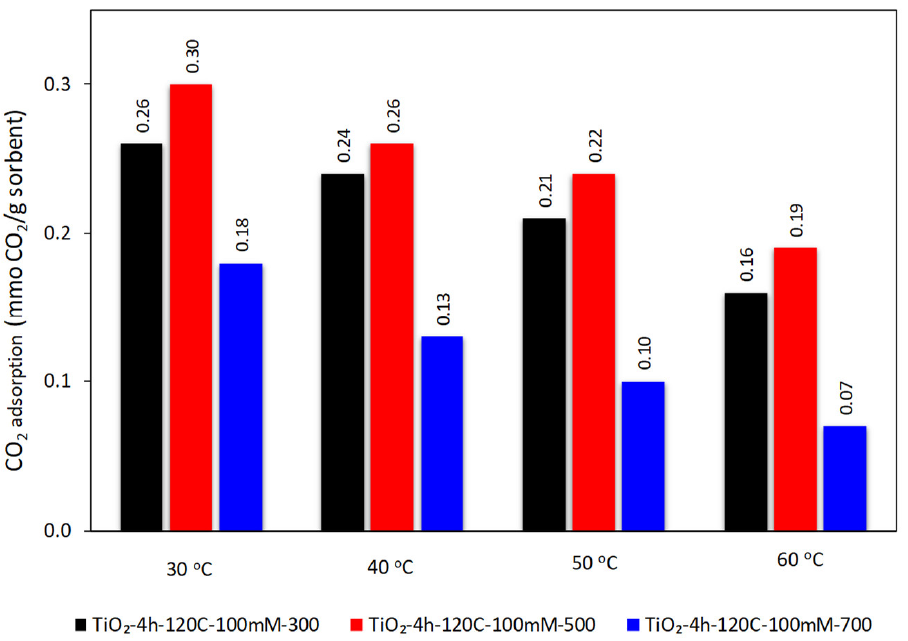
Figure 6. Temperature dependence of CO 2 adsorption capacity.